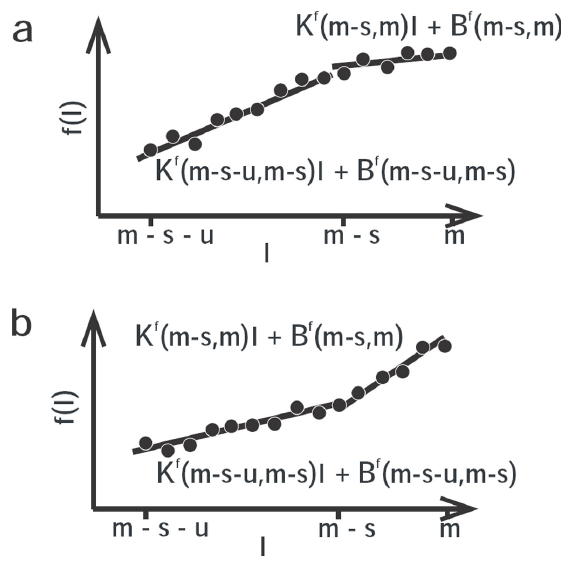
Fig. 20. Definition of changes in background activity for the in- dex f (m) . The two panels illustrate the case when extreme events are associated either (a) with a decline or (b) with an increase in the general trend K f (m − s,m) of { f (l) : m − s ≤ l ≤ m } ; in either case, the change in trend µ f (m ; s,u) is defined as µ f (m ; s,u) = | K f (m − s,m) − K f (m − s − u,m − s) | . Dots show monthly val- ues f (l) , while straight lines are the linear least-square regressions of f (l) on l in the two adjacent intervals (m − s − u,m − s) and (m − s,m) . See Appendix D for